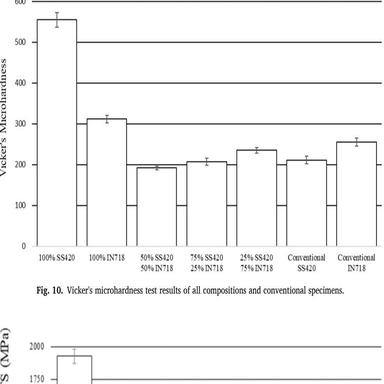
Ultimate tensile strength of all laser-DED processed compositions and conventional samples.